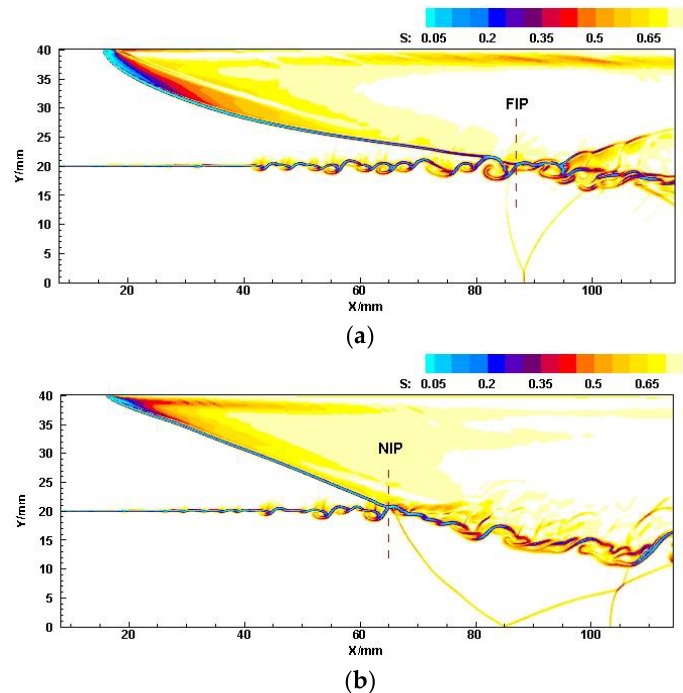
Figure 7. Evolution dynamics of local flow field: ( a ) t = t0; ( b ) t = t0 + 90 μs .